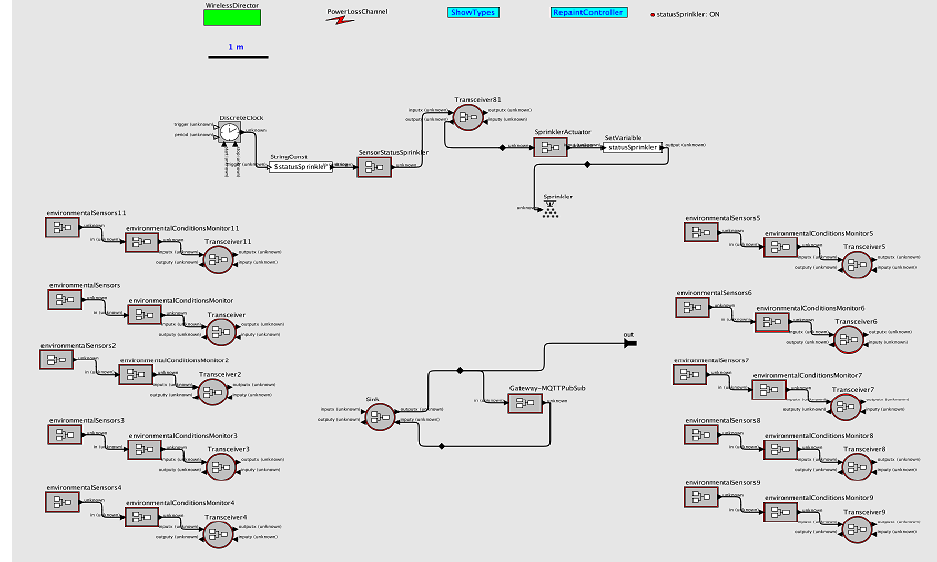
Figure 3. Model of a wireless sensor and actuator network in a park.